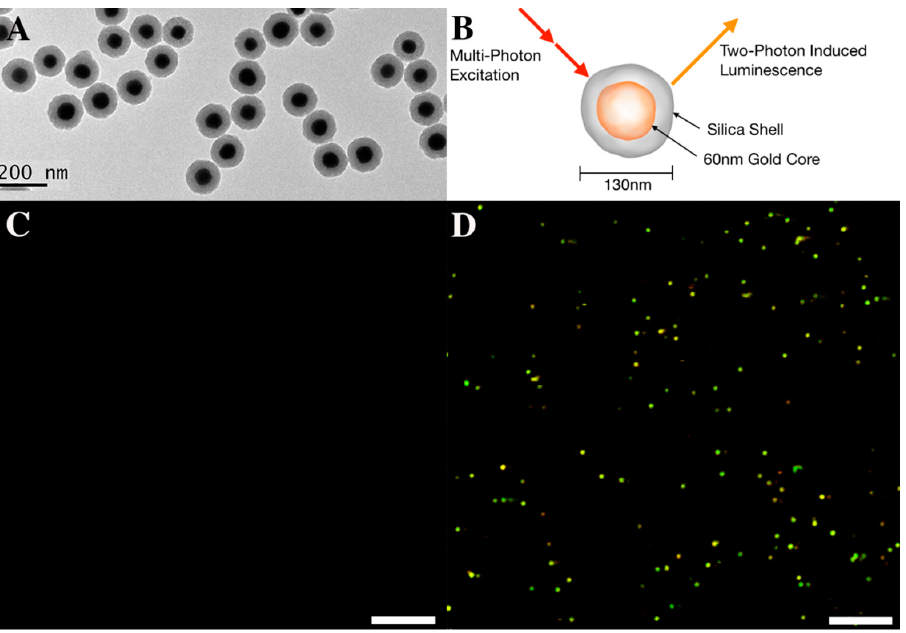
Figure 1. Label-free characterization of multiphoton-induced luminescence from gold–silica nanoparticles. ( A ) TEM image of 130 nm gold–silica nanoparticles. The silica shell is seen as the lighter gray band around a darker 60 nm gold core. ( B ) Diagram of proposed multiphoton luminescent e ff ect in the gold–silica nanoparticles. Note that luminescence is generated only from the gold core. Images in ( C , D ) were acquired with gold–silica NPs prepared on a glass slide. Individual particles are highlighted in a golden hue due to the composite image taken from acquisition channels 446, 525, and 575 nm. Scale bars in panels C and D represent 10 µ